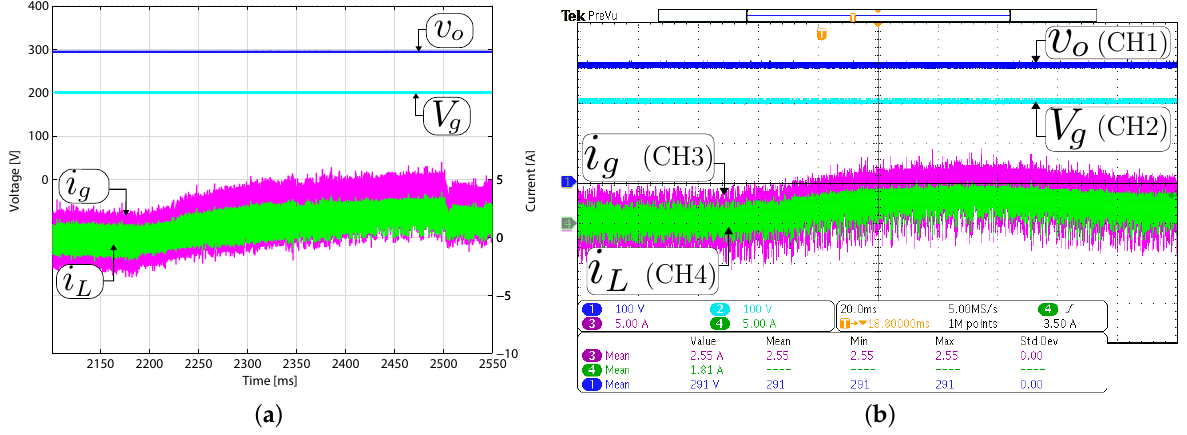
Figure 14. Boost operation mode in steady-state for a step power transition ( P o = 300 to 750 W, V g = 200 V, V o = 300 V) with an EV powertrain system emulation. Simulated ( a ), and experimental ( b ). CH1: V o (100 V/div), CH2: V g (100 V/div), CH3: i g (5 A/div), CH4: i L (5 A/div), and time base of